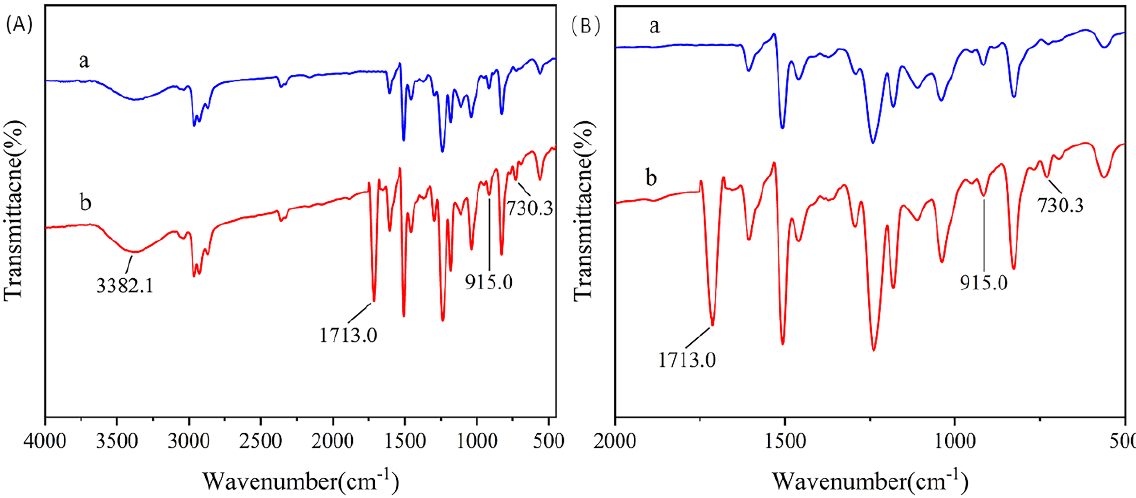
Figure 8. FTIR spectra of epoxy resin and graft copolymer: ( A ) 4000 − 500 cm − 1 and ( B ) 2000 − 500 cm − 1 .